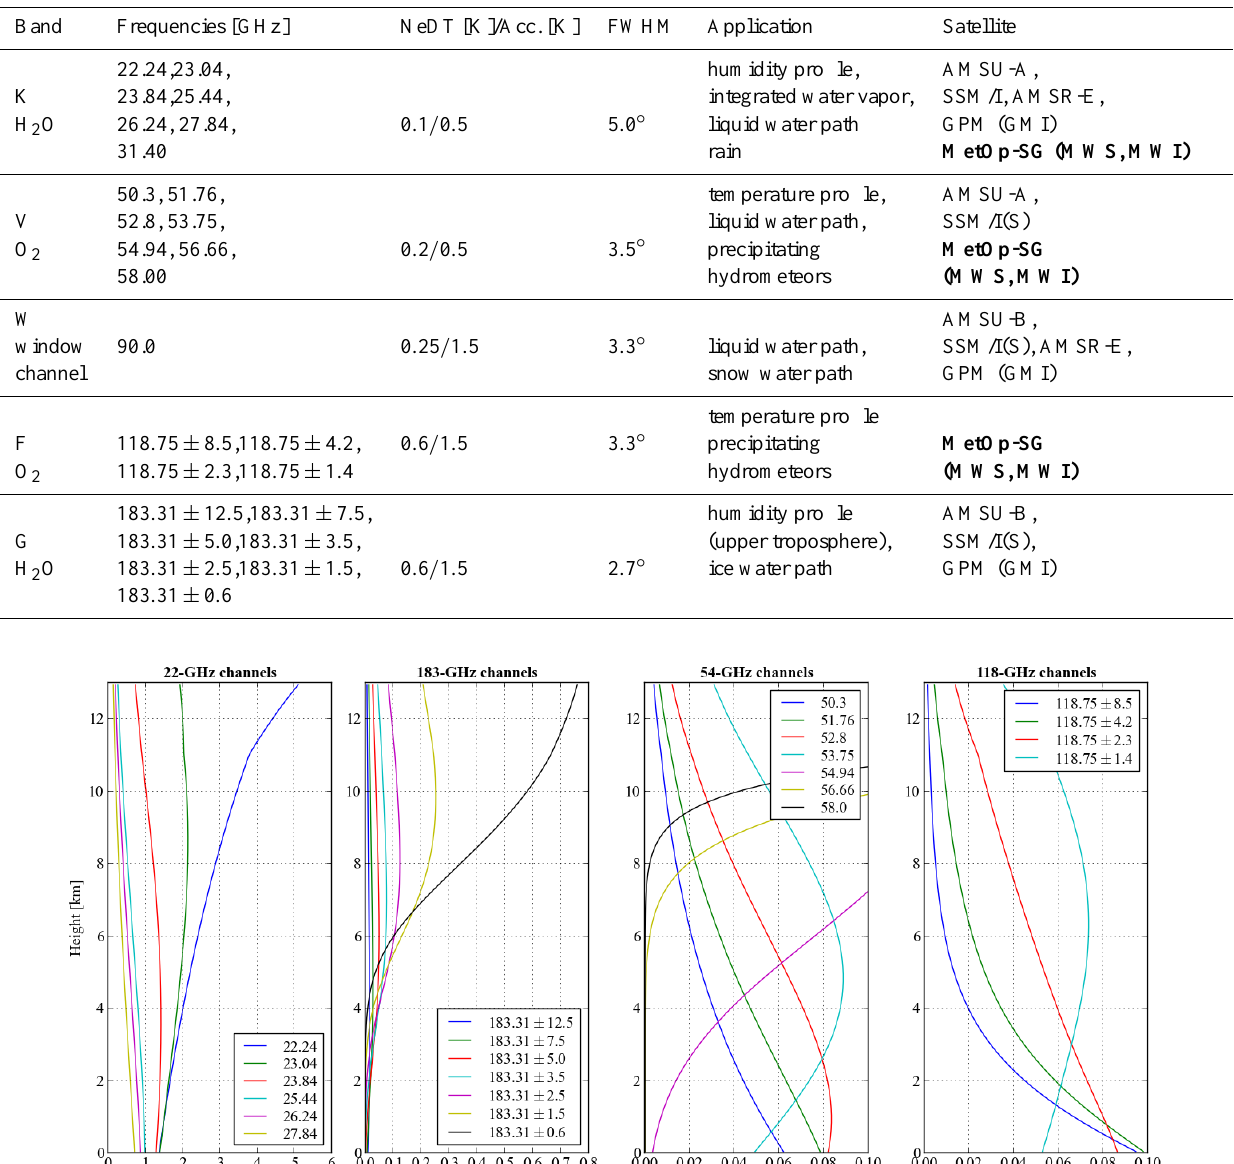
Table 2. HAMP passive bands with their noise-equivalent delta temperature (NeDT), absolute accuracy (Acc.), beam width (full width at half maximum, FWHM), their main use in retrieving atmospheric variables, and corresponding satellite instruments. Upcoming missions (instruments) are shown in bold letters.